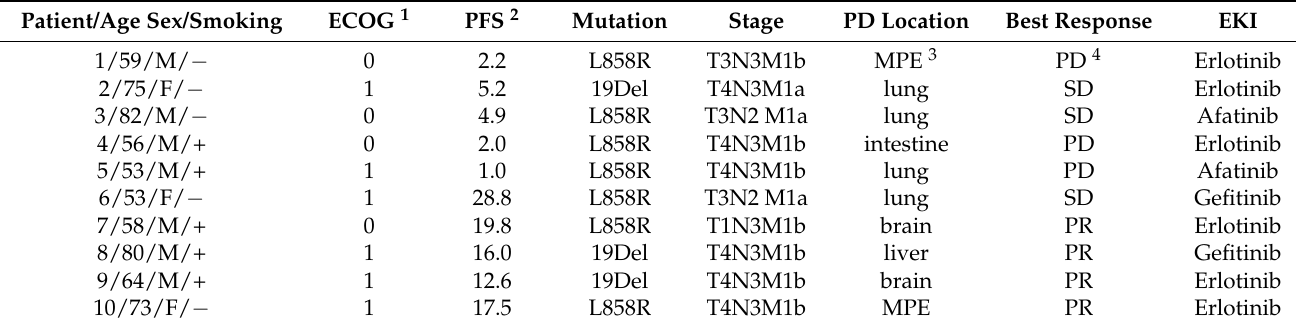
Table 1. Clinical characteristics of enrolled